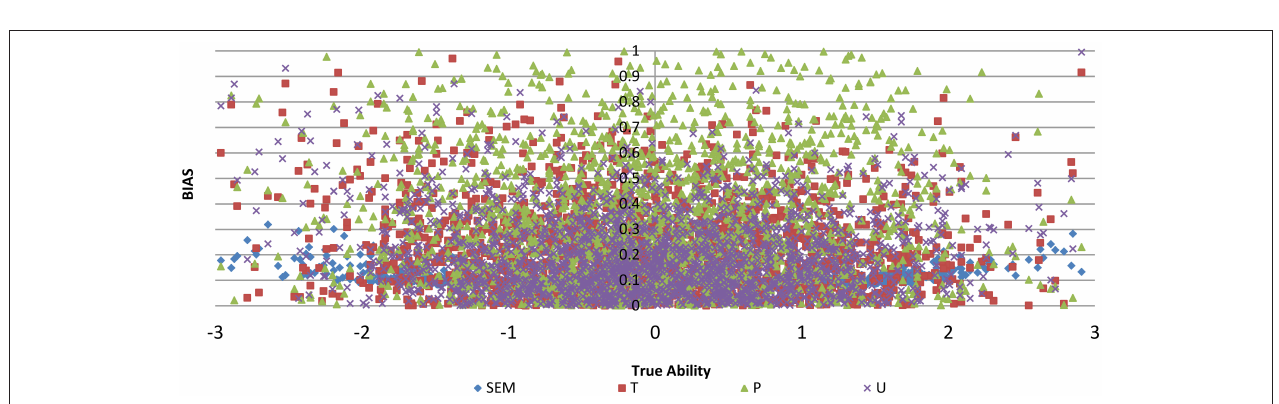
FIGURE 3 | Reliability, BIAS, empirical SE, and SEM for test length of 10, 20, and 30 for all 9 procedures for selection method M3: Note about the x-axis for the 9 procedures: 1, Testlet model; 2, Testlet model with 0.2 as item exposure rate using PI; 3, Testlet model with 1.0 as item exposure rate using PI; 4, Passage model; 5, Passage model with 0.2 as item exposure rate using PI; 6, Passage model with 1.0 as item exposure rate using PI; 7, UIRT model; 8, UIRT model with 0.2 as item exposure rate using PI; 9, UIRT model with 1.0 as item exposure rate using PI.